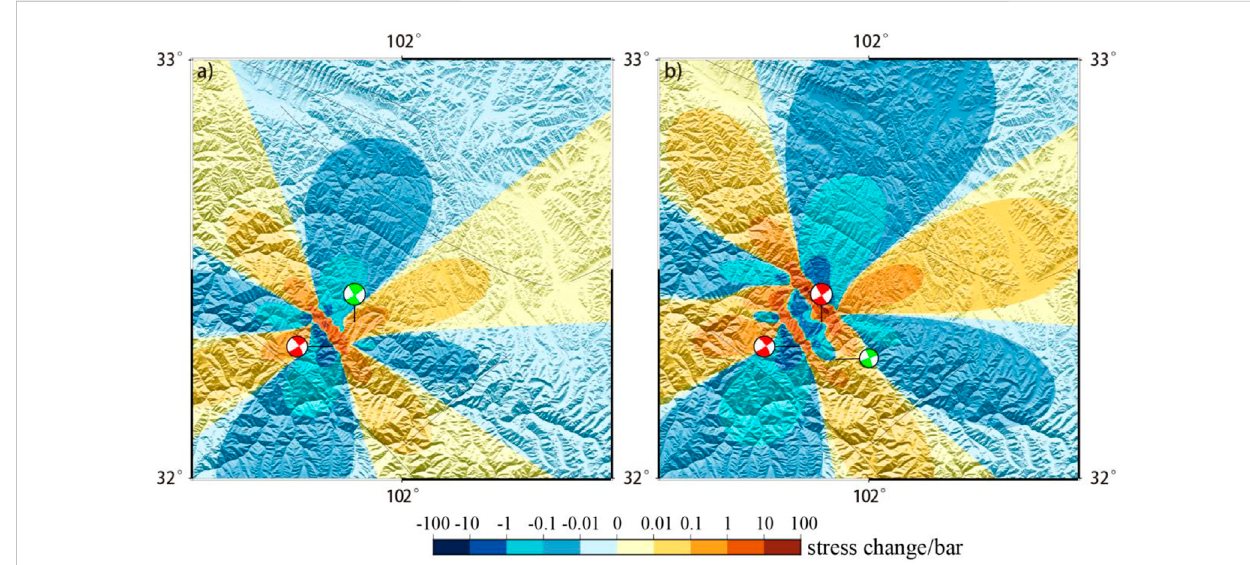
FIGURE 5 ContourmapoftheCoulombstresschangeinthethreesuccessiveMaerkangearthquakesin2022. (A) CoseismicCoulombstresschangeintheM W 5.6 Maerkang earthquake resulting from the M W 5.9 Maerkang earthquake. (B) Coseismic Coulomb stress change of the M W 4.9 Maerkang earthquake resulting from the M W 5.6 and M W 5.9 Maerkang